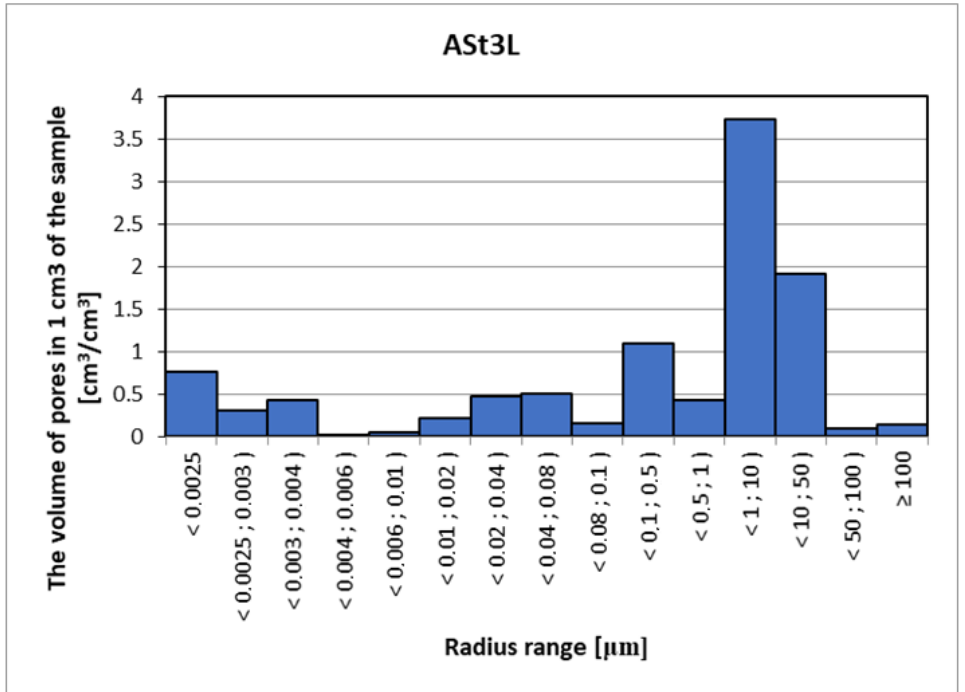
Figure 18. Distribution of the volume and range of pore radii for 50% GS modified silicate brick (i.e., 50% QS + 50% GS in relation to the share of sand (90%) in the total silicate mass, the remaining 10% being 7% CaO and 3% H 2 O).